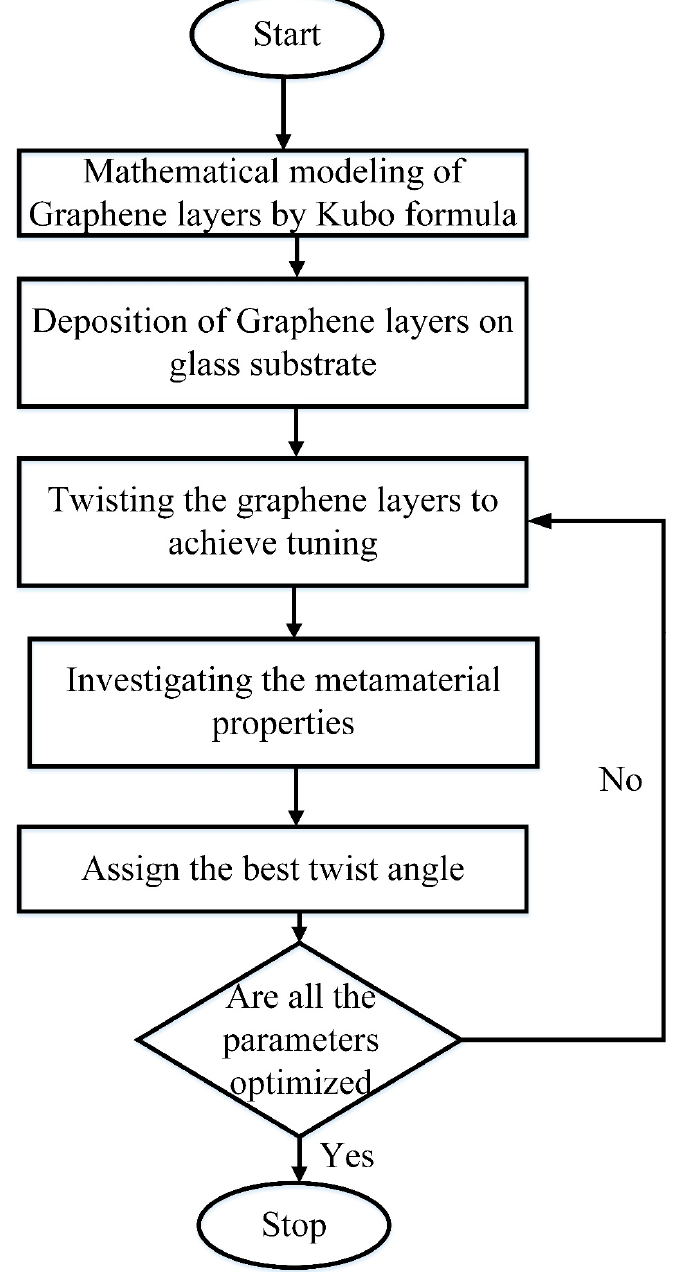
Figure 2. Flowchart describing the graphene twistronics modeling and investigation methodology for achieving the optical properties.